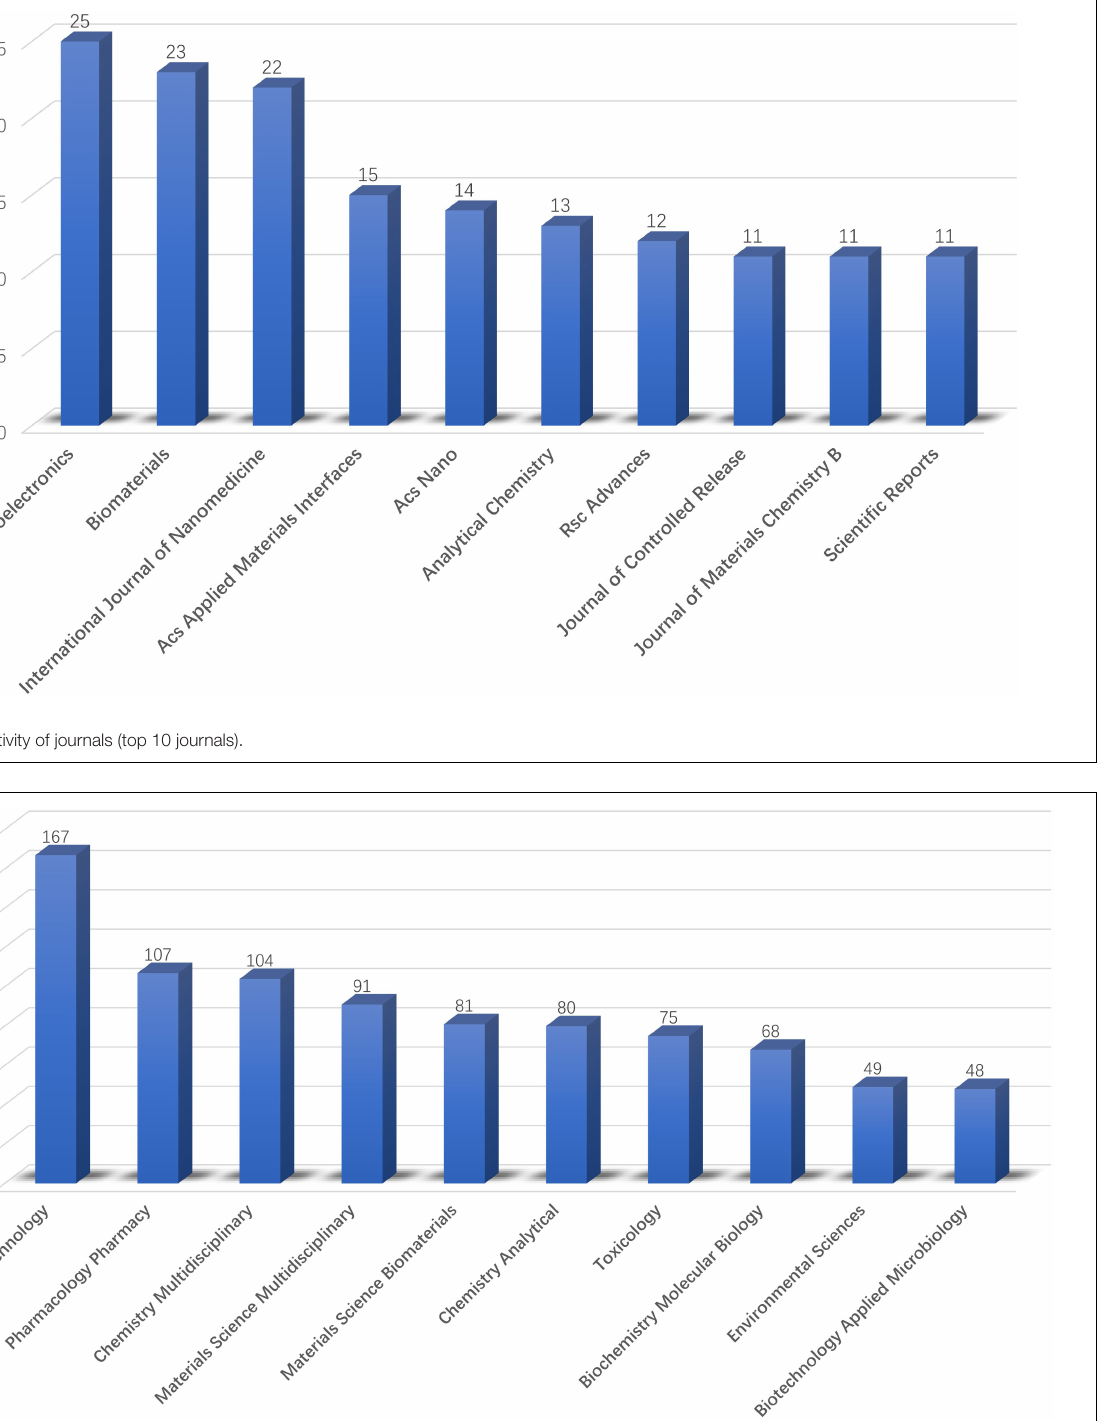
FIGURE 6 | The top 10 research